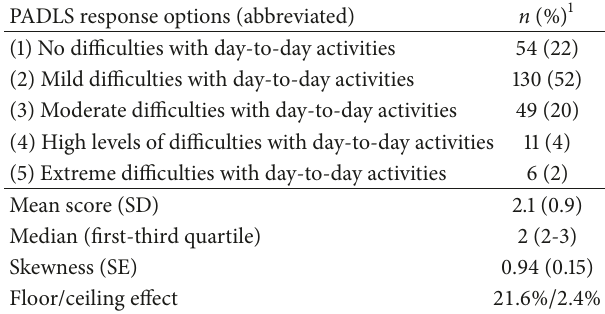
Table 2: Score distribution of the Parkinson’s disease Activities of Daily Living Scale